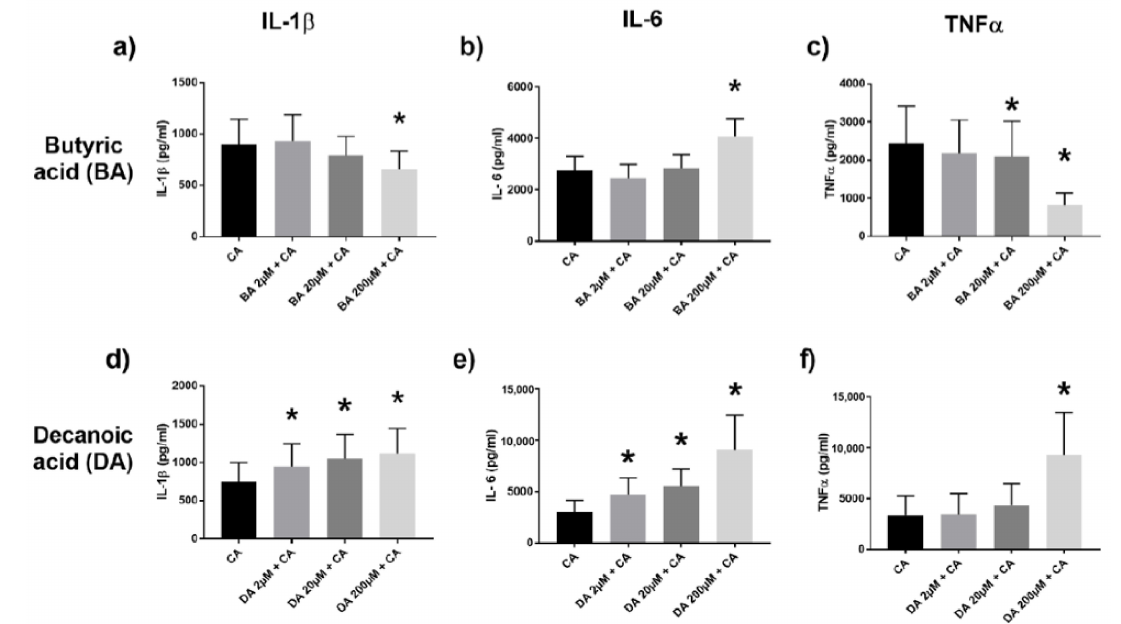
Figure 3. Proinflammatory cytokine IL-1 β , IL-6, and TNF α production in the supernatants of PBMC co-stimulated with Candida albicans (CA) and various dilutions of butyric acid (BA) ( a – c ), or decanoic acid (DA) ( d – f ), assessed by ELISA. Values are presented as mean ± SEM, results from at least 7 subjects were used. Wilcoxon signed rank test was used to determine significance for pair-wise comparisons with the control CA group, * p < 0.05 is the cytokine level difference compared to the control CA group (black bar).